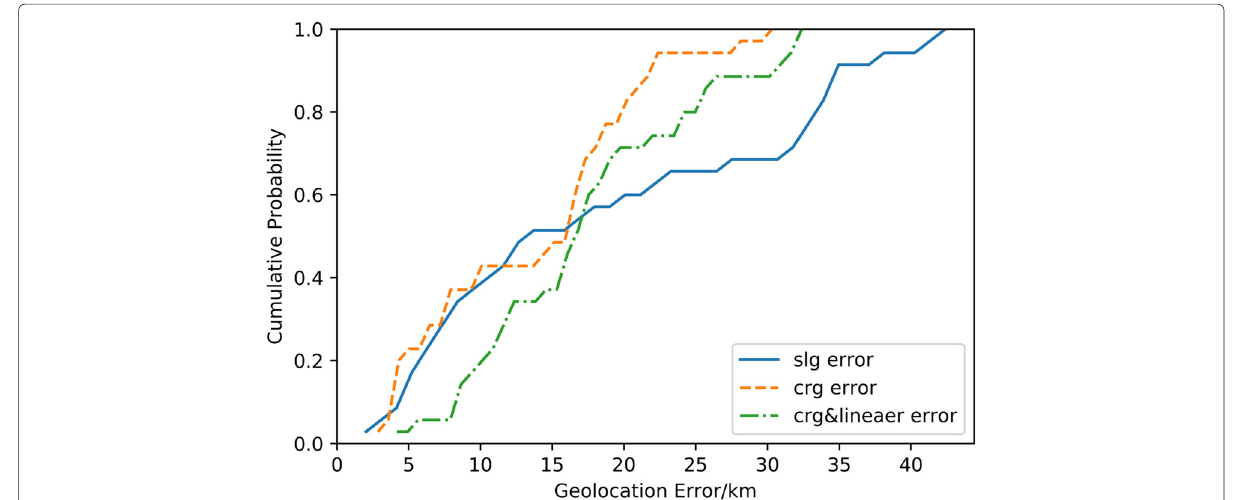
Fig. 10 Comparison of cumulative probability of SLG, CRG and CRG with linear estimation in 5%